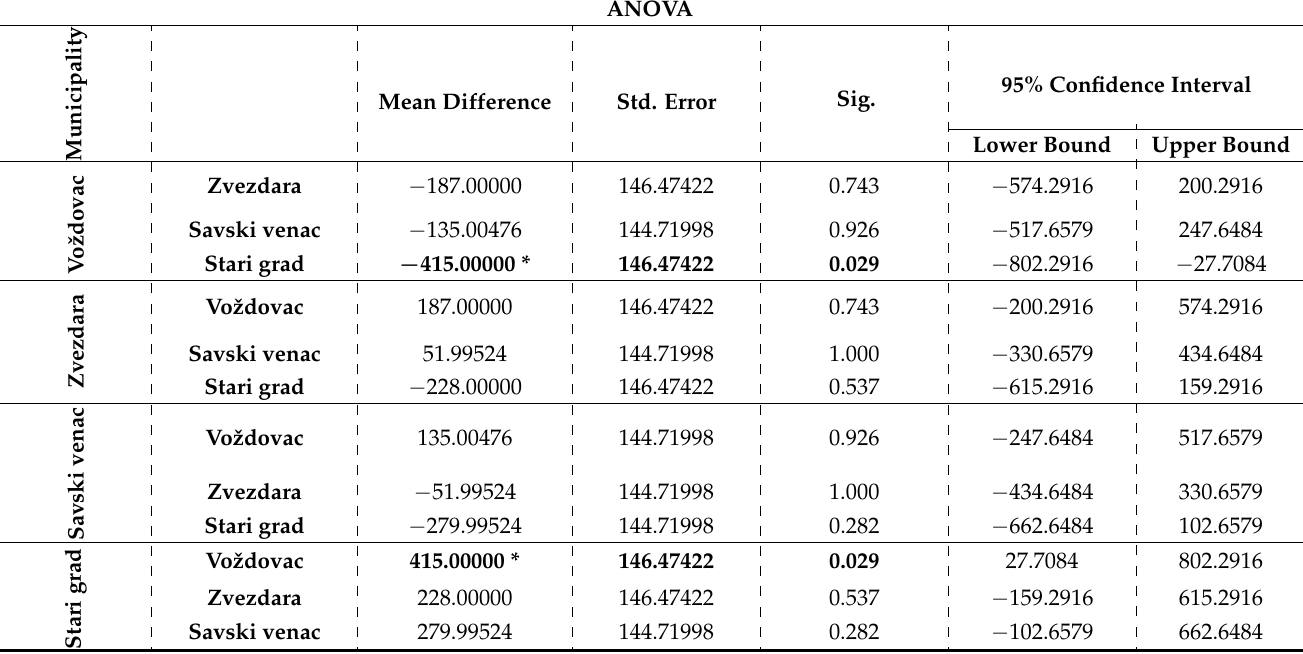
Table 4. Analysis of variance for the amount of money spent monthly per municipality. ANOVA